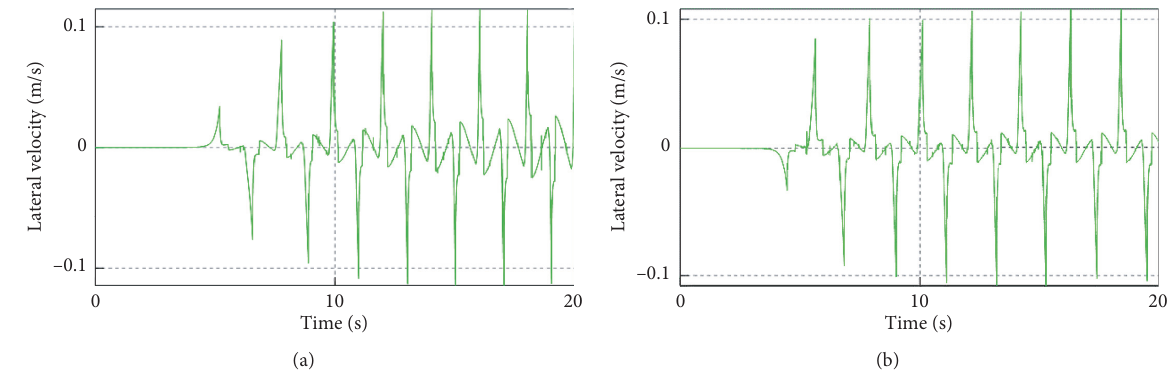
Figure 18: Changes of the lateral velocity under different guide wheel treads: (a) 340mm and (b) 540 mm.